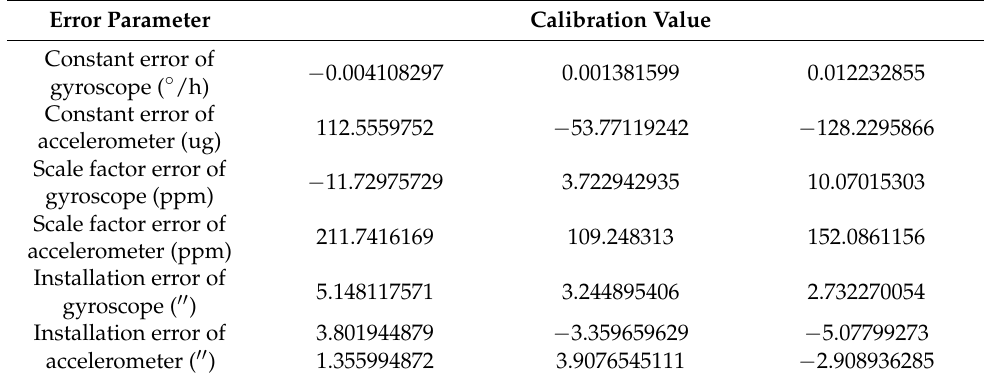
Table 4. The error parameter estimate of the